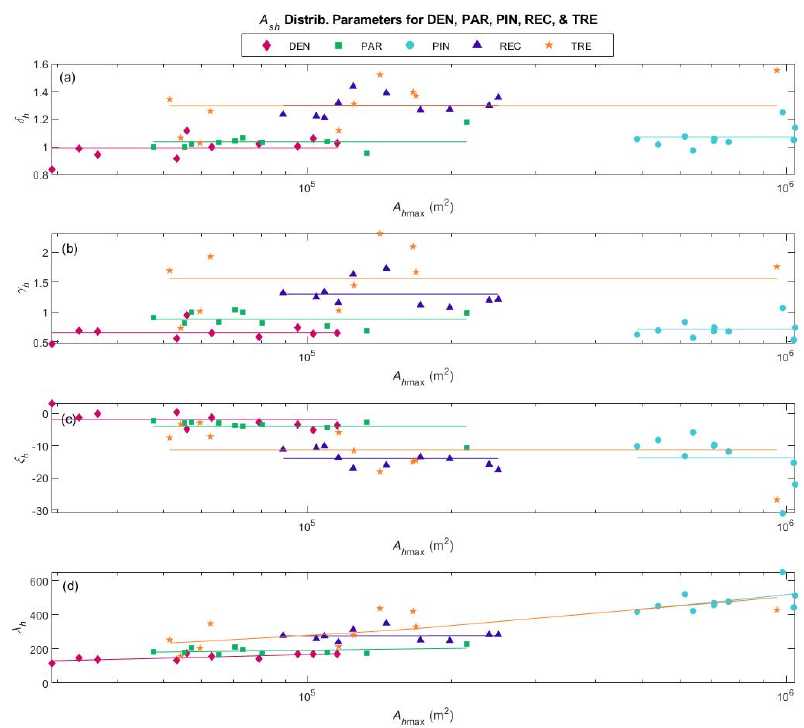
Figure 4. Parameters ( a ) δ h , ( b ) γ h , ( c ) ξ h , and ( d ) λ h of the Johnson SB distribution for A sh plotted against the maximum hillslope area A h max . The symbols show the calibrated parameter values for each basin. The horizontal lines in ( a – c ) show the average parameter value for each network type. The lines in ( d ) show power functions fitted to the λ h values for each network type.